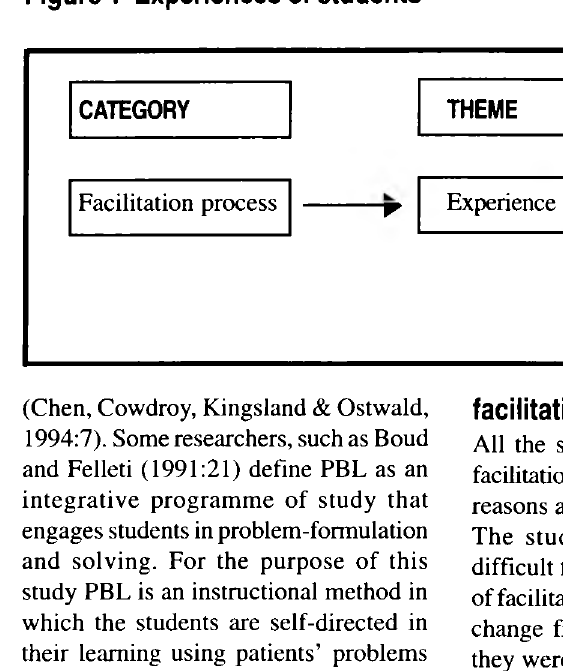
figure 1. The following excerpts